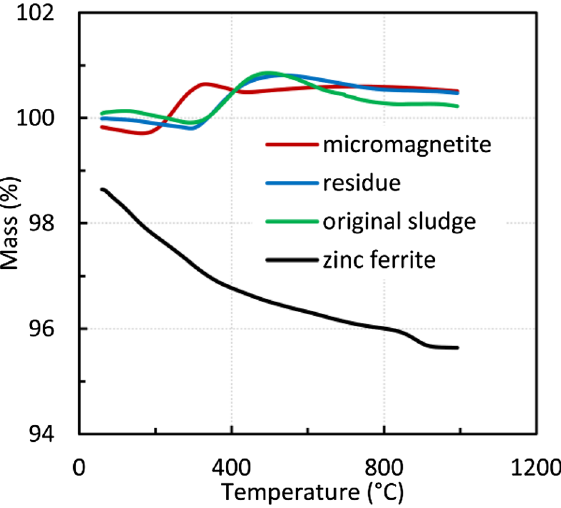
Figure 5. Thermal analysis of the sludge, zinc ferrite, solid residue, and micromagnetite, 10 °C min −1 .